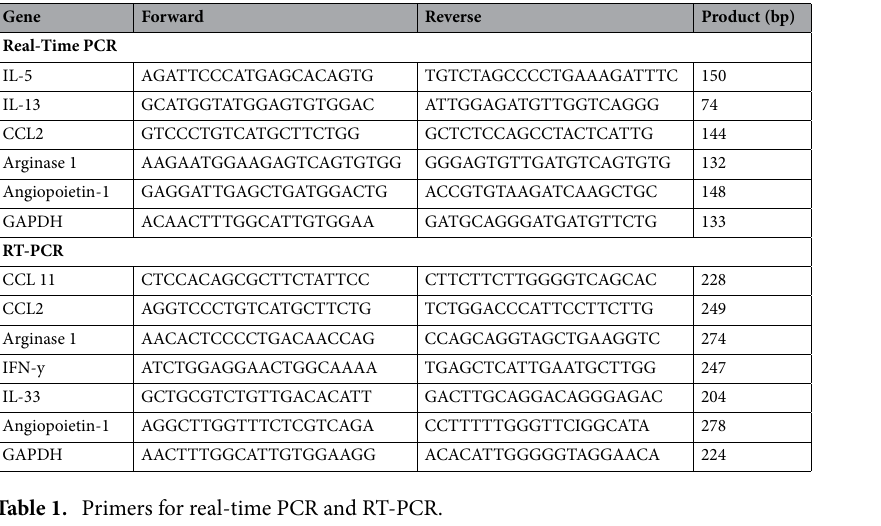
and the intensity of the bands and the ratio of specific mRNA to β-Actin were analyzed with the Bio-Rad Gel Doc system and the Quantity One 4.4.1 software (Bio-Rad Laboratories, Hercules, CA). The ∆∆Ct method was used for quantitative PCR. Reactions were carried out in an ABI 7900 real-time PCR system (Life Technologies, Carlsbad, CA) and values were expressed relative to house-keeping gene GAPDH. Primer sequences for RT-PCR and quantitative real-time PCR are shown in Table 1.